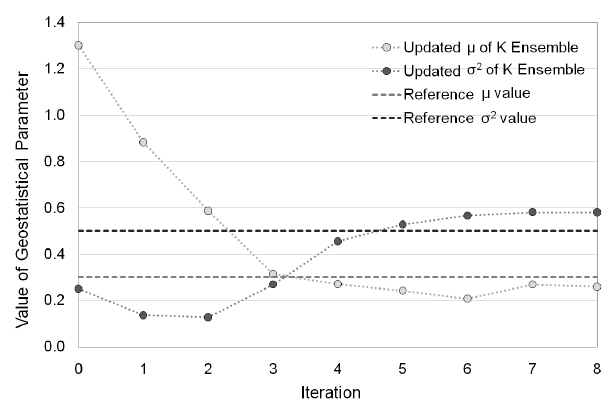
Fig. 12. Comparison of reference and updated values of Y K along the Y = 2000 m transect where the true is higher (1.801 log m day − 1 ) and lower (0.801 log m day − 1 ) than the of the forecast en- semble (1.301 log m day − 1 ). The values from the reference state are shown in red, and the updated values are shown in blue. For both scenarios, 24 WT measurements are assimilated.